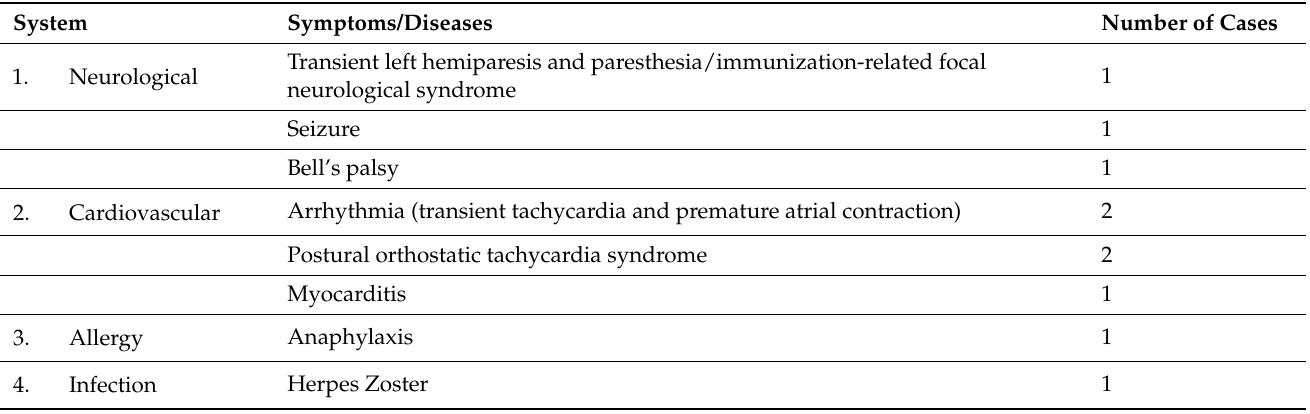
Table 2. Unsolicited events within 30 days of the full vaccination procedure.